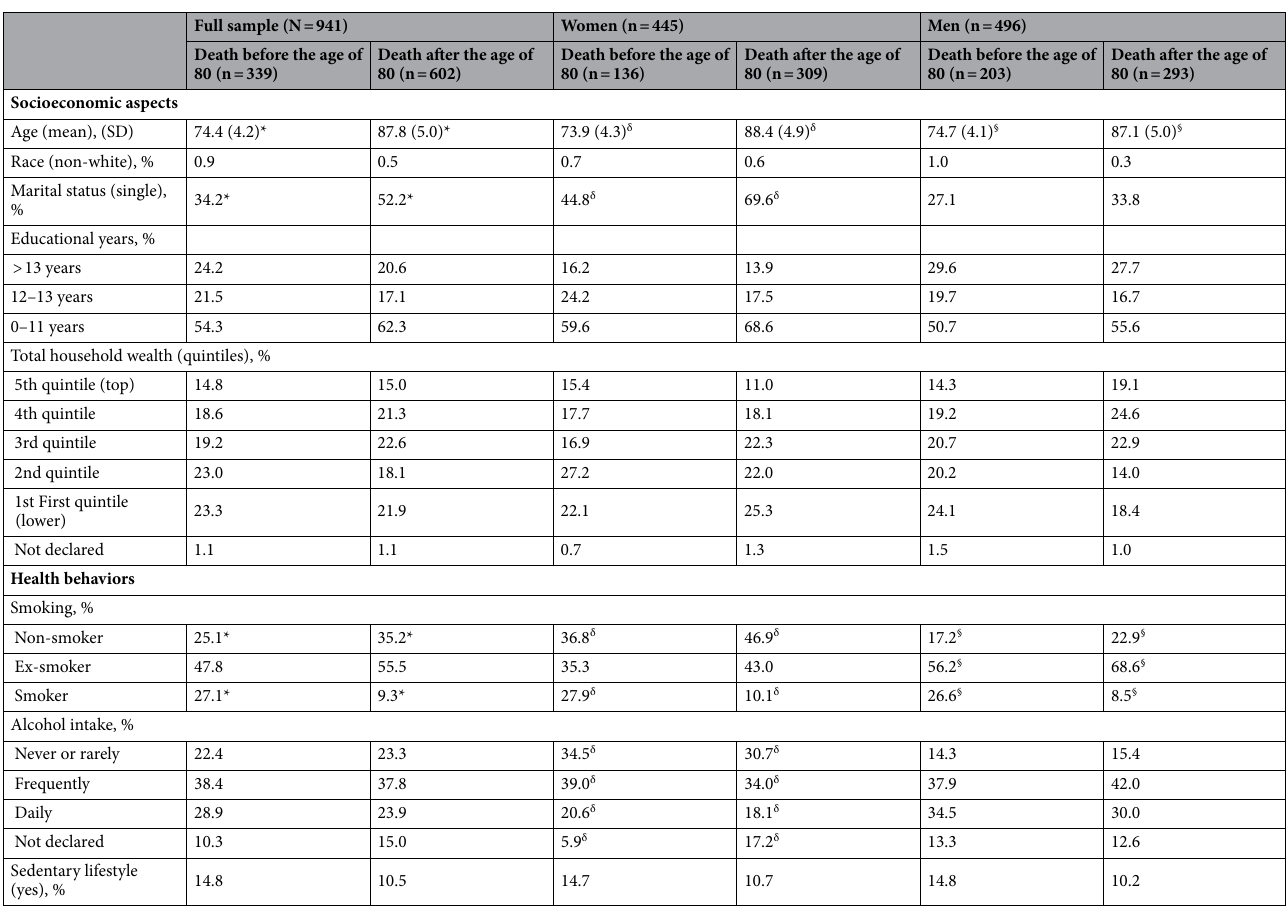
Table 1. Baseline socioeconomic and behavioral characteristics who died before and after the age of 80 during 12-month follow-up. *Differences between full sample in category ’death before the age of 80’ versus full sample in category ’death after the age of 80’. δ difference between women in category ’death before the age of 80’ versus women in category ’death after the age of 80’. § difference between men in category ’death before the age of 80’ versus men in category ’death after the age of